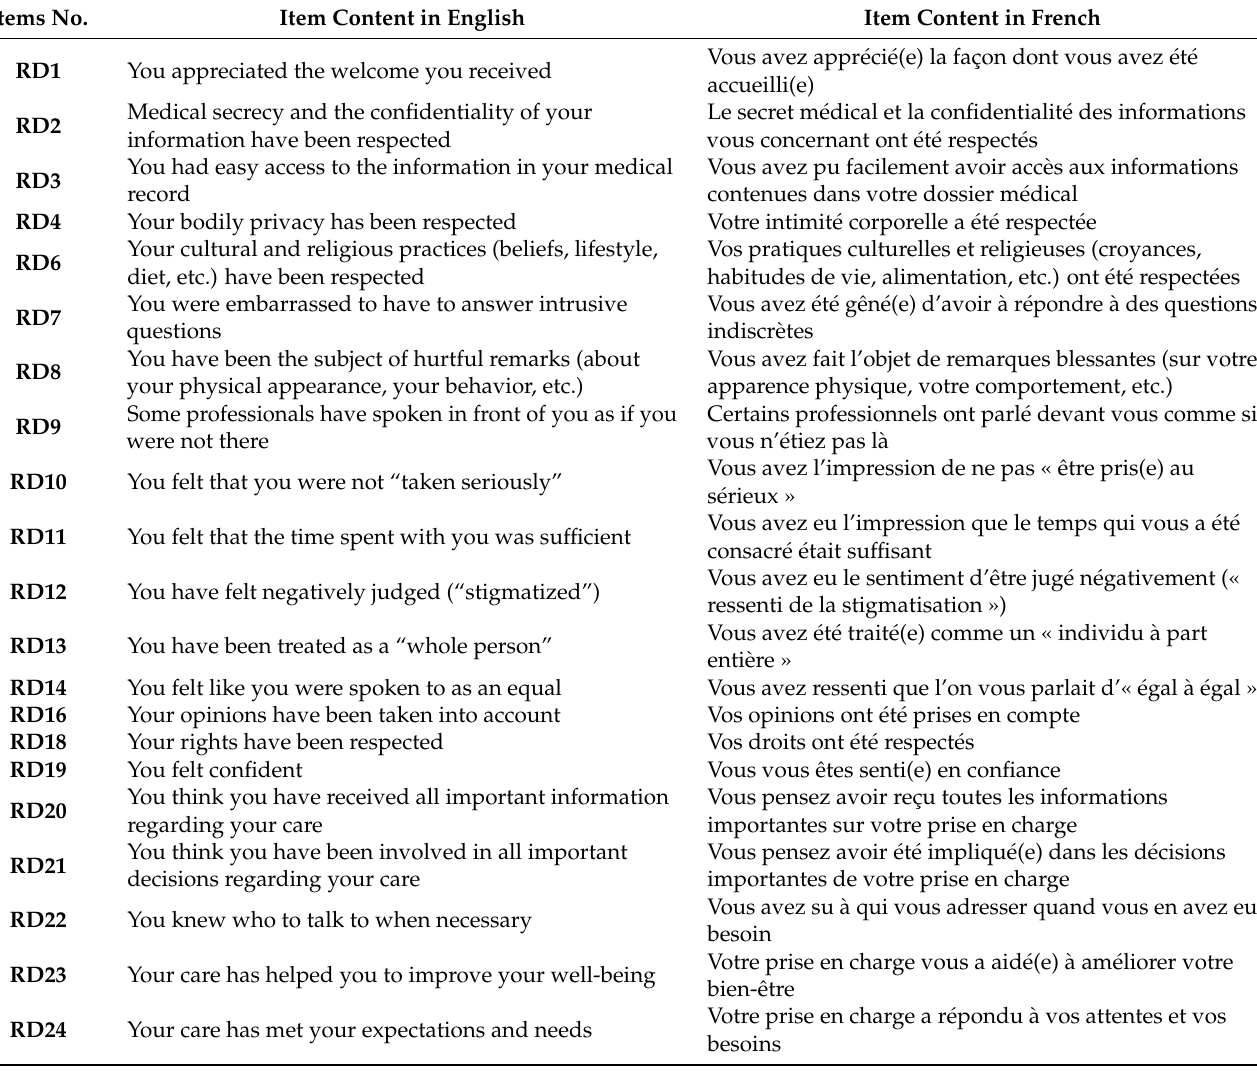
Table A3. List of the 21 items of the PREMIUM-RD item bank (English and French